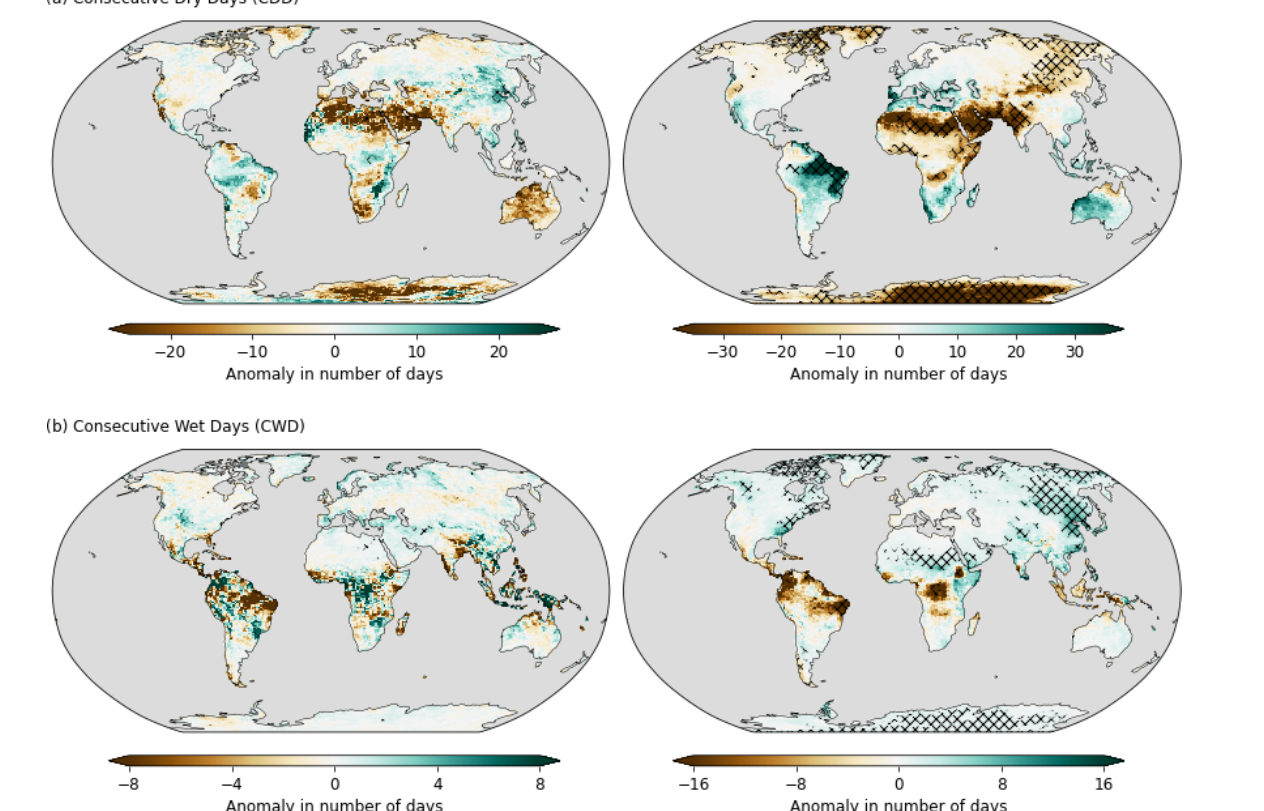
Figure 7. Similar to Fig. 2, but for projected changes in (a) the longest spell of dry days (CDD) and (b) longest spell of wet days (CWD). Hatching indicates significance at the 5% test level using the Student’s t